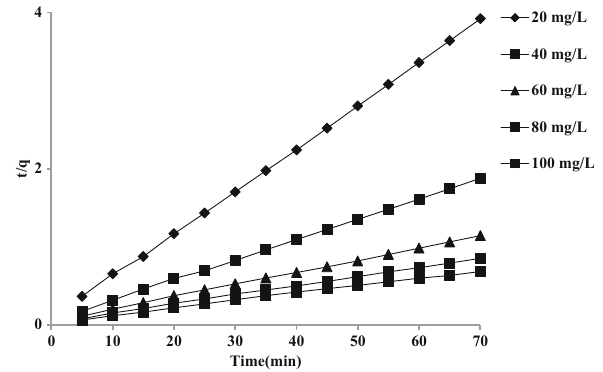
Fig. 8 Plot of linear pseudo-second-order kinetic model at different MB concentrations. C-ZMN adsorbent: 0.8 g/50 mL;